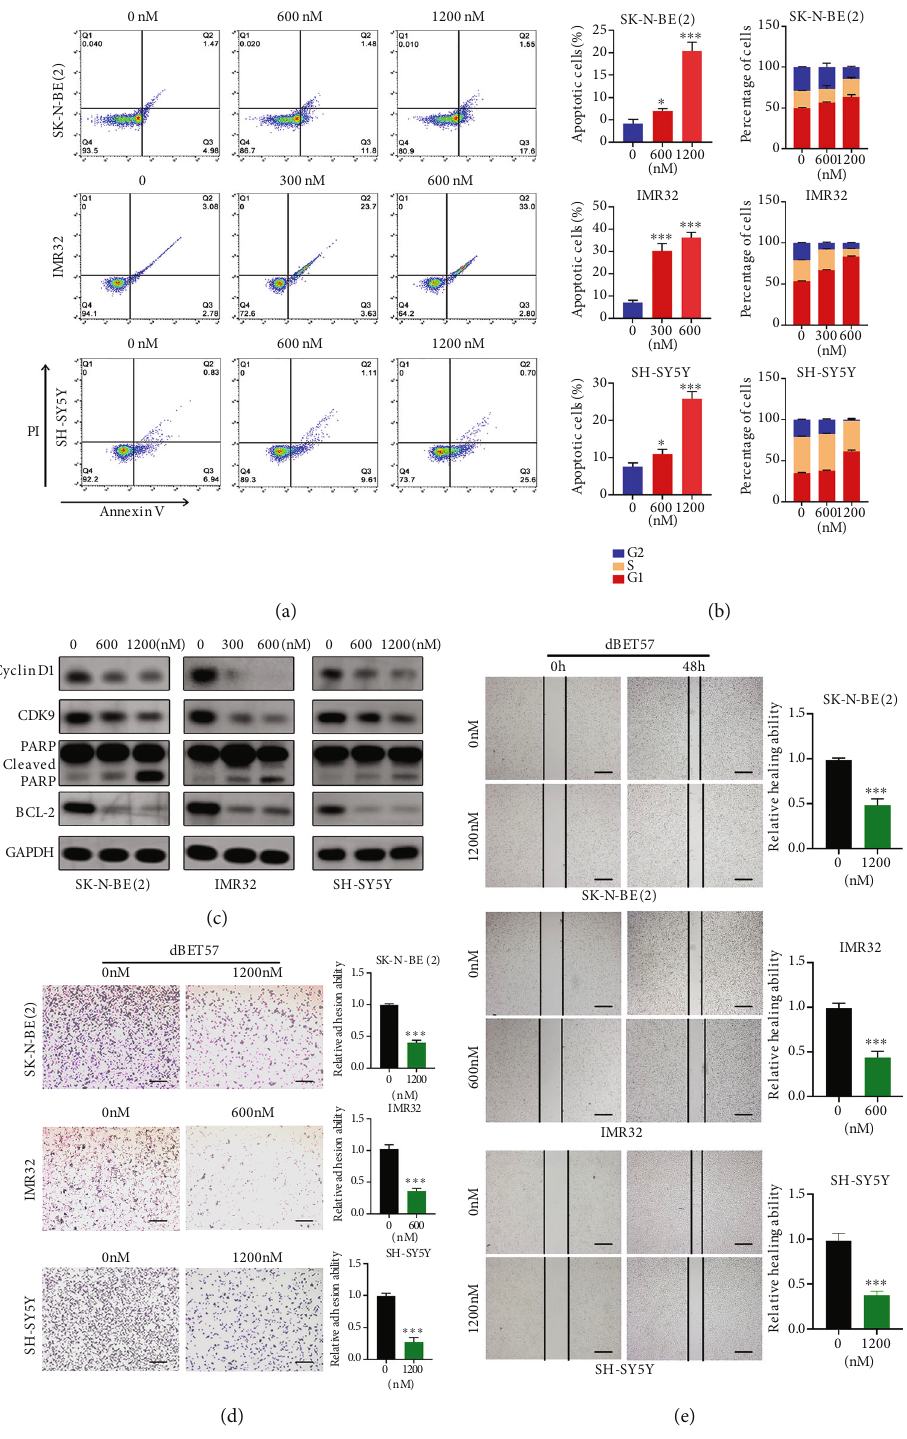
Figure 2: dBET57 induced apoptosis, inhibit normal cell cycle and migration ability of NB cells. NB cells were treated with di ff erent concentration gradients of dBET57 for 48h. (a) Flow cytometry and Annexin V/PI staining were used to analyze the degree of apoptosis of NB cells. (b) Flow cytometry and PI staining were used to analyze the cell cycle distribution of NB cells. (c) Western blotting showed the protein level expression of Cyclin D1, CDK9, Bcl-2, and cleaved PARP in NB cells. (d) Adhesion assay to evaluate the adhesion ability of NB cells. Scale bars: 200 μ m. (e) Scratch experiment evaluate the migration ability of NB cells. Scale bars: 100 μ m. The experimental groups (di ff erent concentration gradients of dBET57) were compared with the control group (0 nM). ∗ p < 0 : 05 , ∗∗ p < 0 : 01 , and ∗∗∗ p < 0 : 001 ; ns: not signi fi